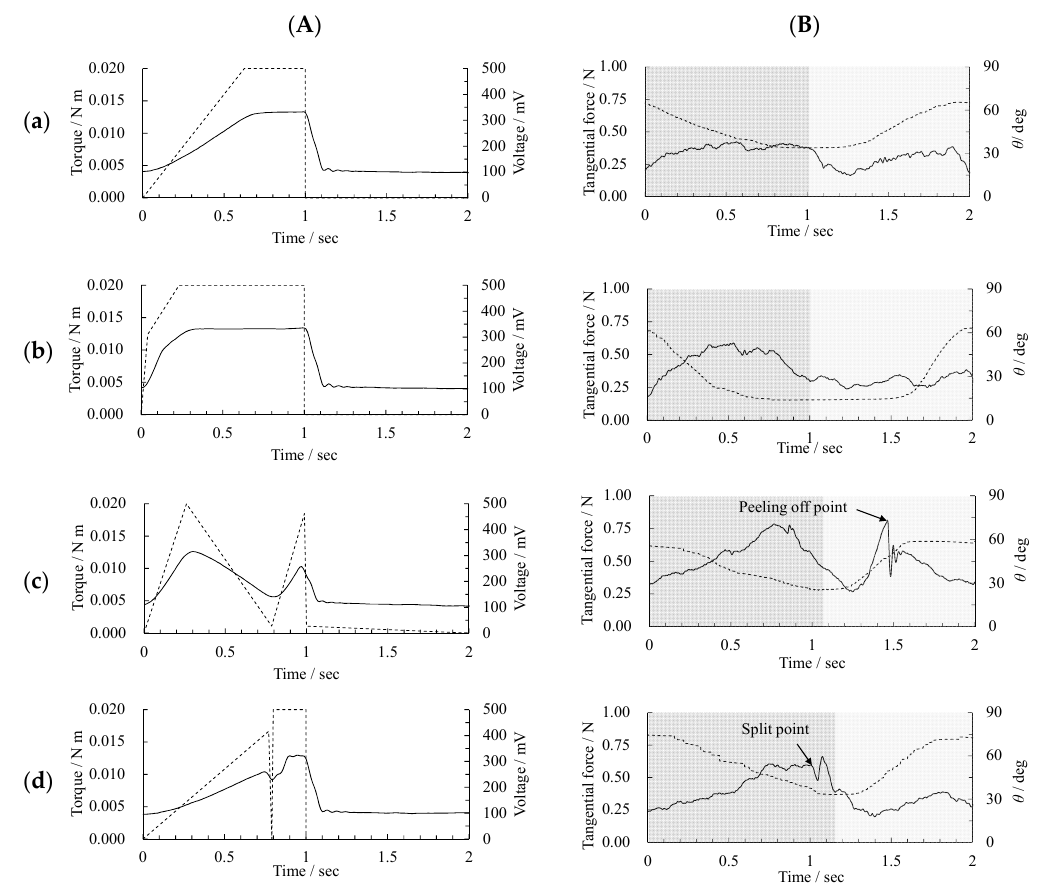
Figure 6. Tactile display during the grasping/cutting process. ( A ) Change in the torque (solid lines) and the applied voltage (dotted lines) over time. ( B ) Change in the tangential force (solid lines) and θ (dotted lines) when a subject operates the scissors-type haptic device. Dark gray zones indicate the closing phase and light gray zones indicate the opening phase of the handle ring. Each voltage pattern is as follows: ( a ) one-step increase pattern, ( b ) two-step increase pattern, ( c ) double peak pattern, and ( d ) drastic decreasing pattern.